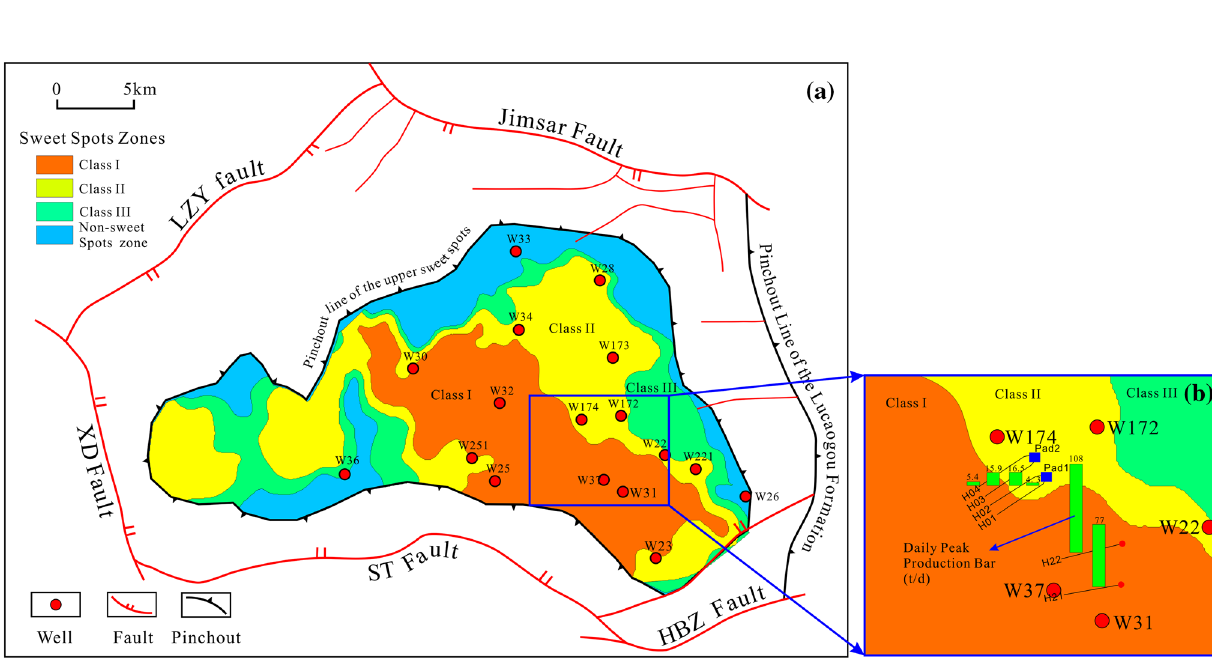
Fig. 9 a Evaluation map of the upper sweet spots of the Lucaogou Formation and b the daily peak production of the development pilot test